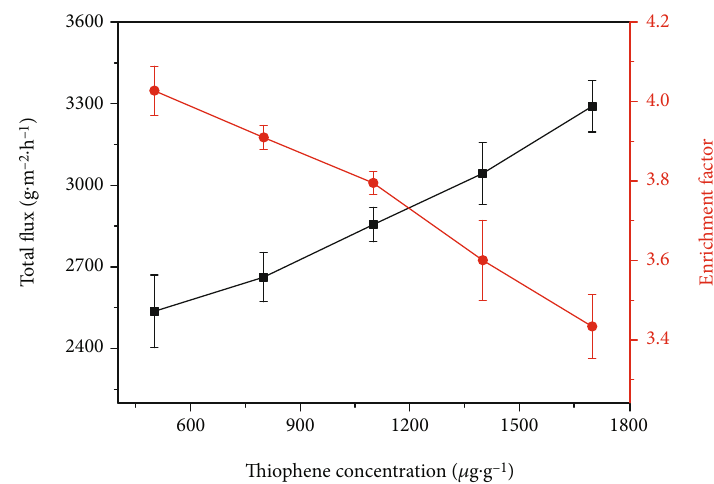
Figure 11: E ff ect of thiophene concentration in feed on desulfurization performance of PEG/MYNS